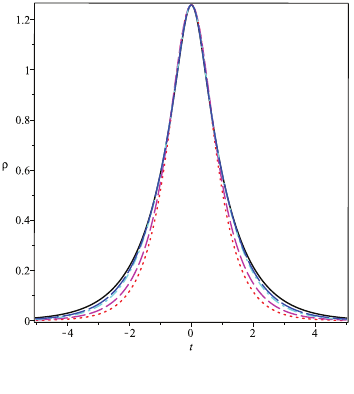
Figure 1. Comparison of various approximations of the homoclinic solution of Eq. (3.3) to the exact solution (solid black line) for ω = σ = 1 . The red dotted, magenta dashed, cyan dash-dotted and blue long-dashed lines correspond to Eq. (3.6), Eqs. (3.8)-(3.9), Eqs. (3.10), and Eqs. (3.11)